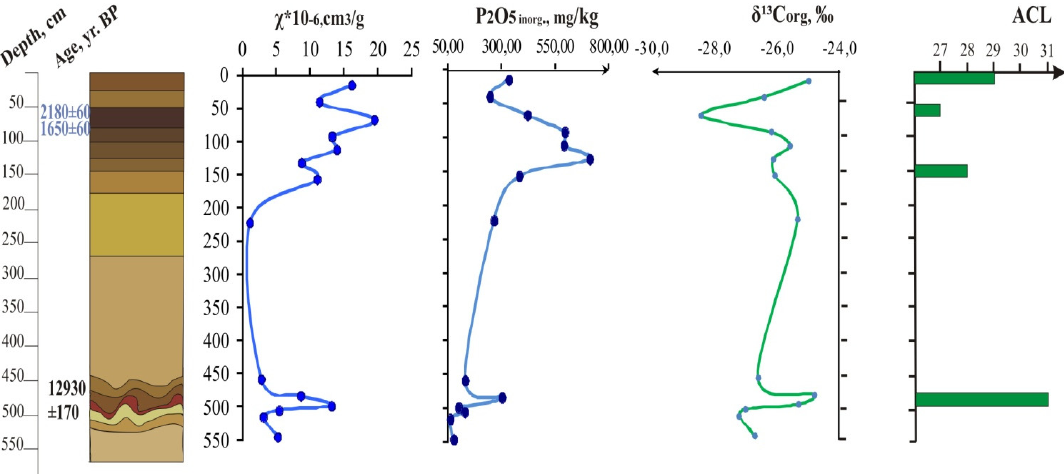
Figure 4. Loess ‐ paleosol sequence with micro ‐ depression (on the top), Krasnoe quarry, magnetic susceptibility, inorganic phosphorus, stable carbon isotope curves, average chain length in n ‐ alkane distribution.